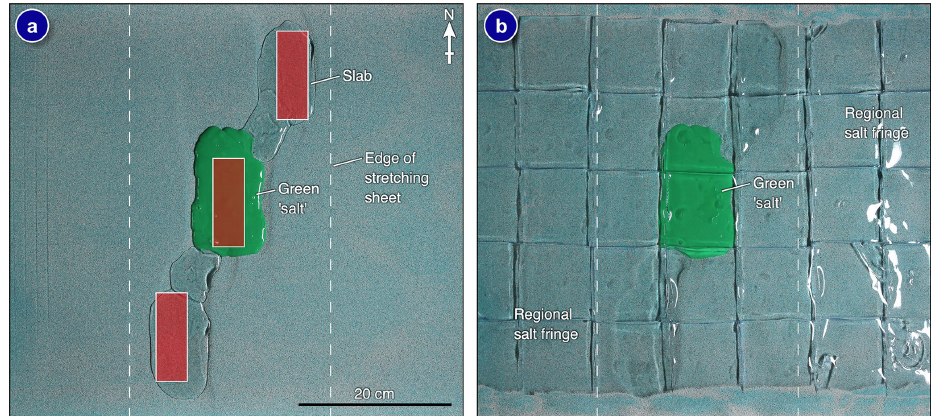
Figure 4. Emplacement of syn-rift salt in Model 1. (a) Pre-salt graben are infilled with our salt analog. Colored silicone was emplaced in the central graben system in order to track flow in the final cross-section views. (b) A regional salt fringe is then emplaced across the entire